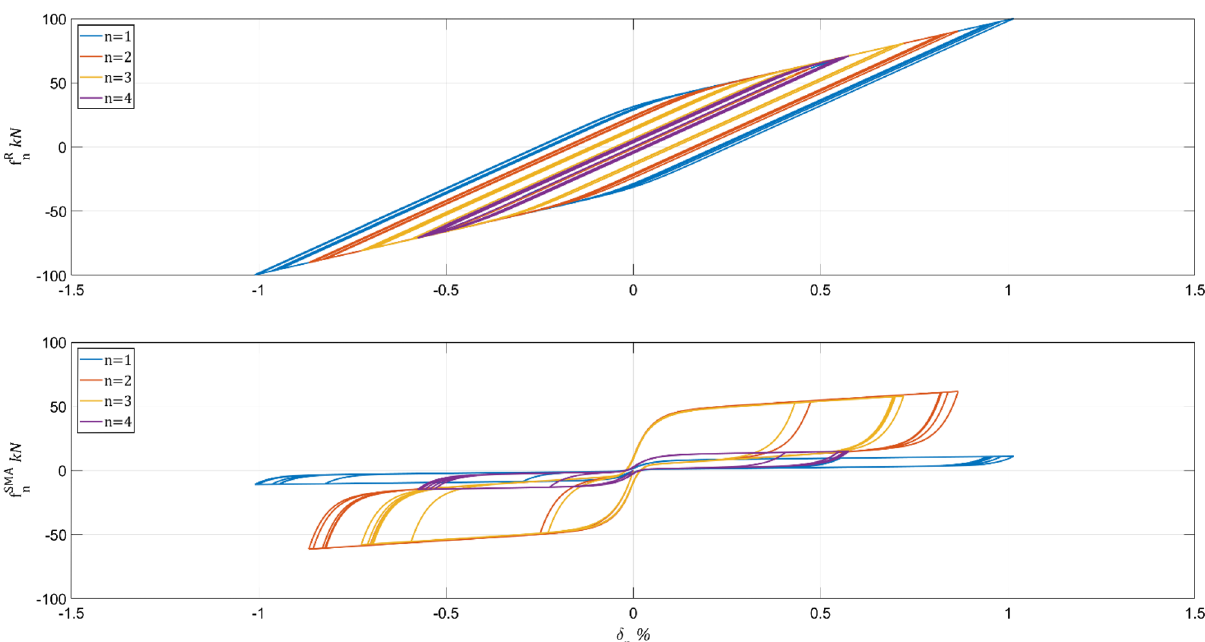
Figure 5. Hysteretic behavior of final SMA allocation with Q 1 = I , Q 2 = I , Q 3 = I , Q 4 = I